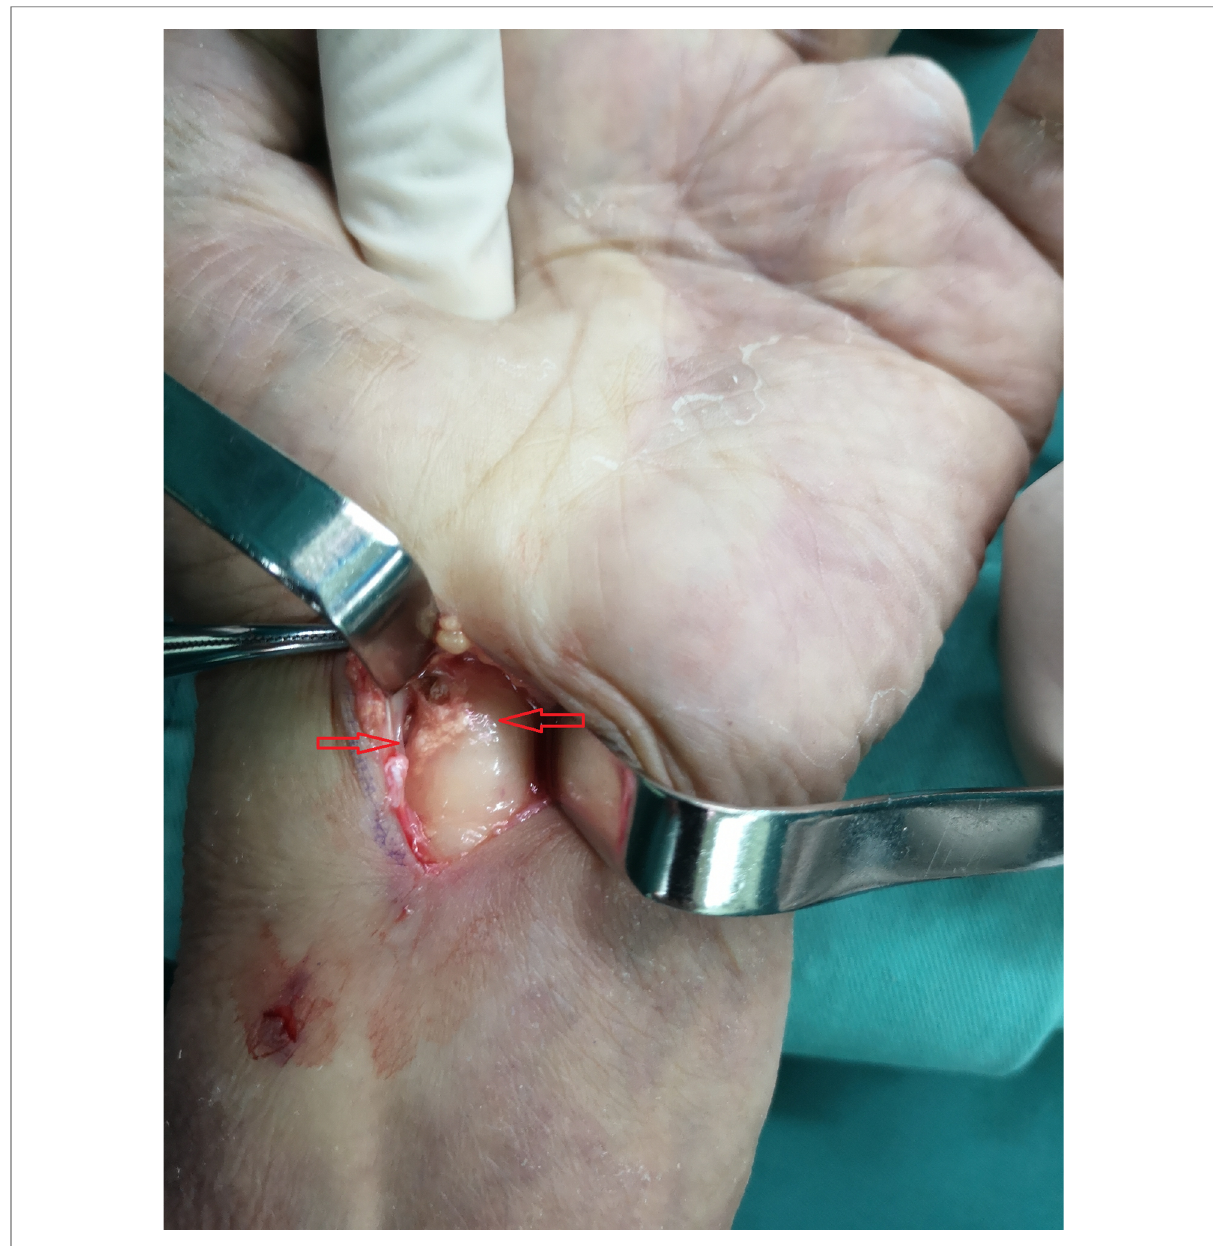
FIGURE 2 Operative fi ndings: gout tophi (red arrows) deposited under the epineurium of the median